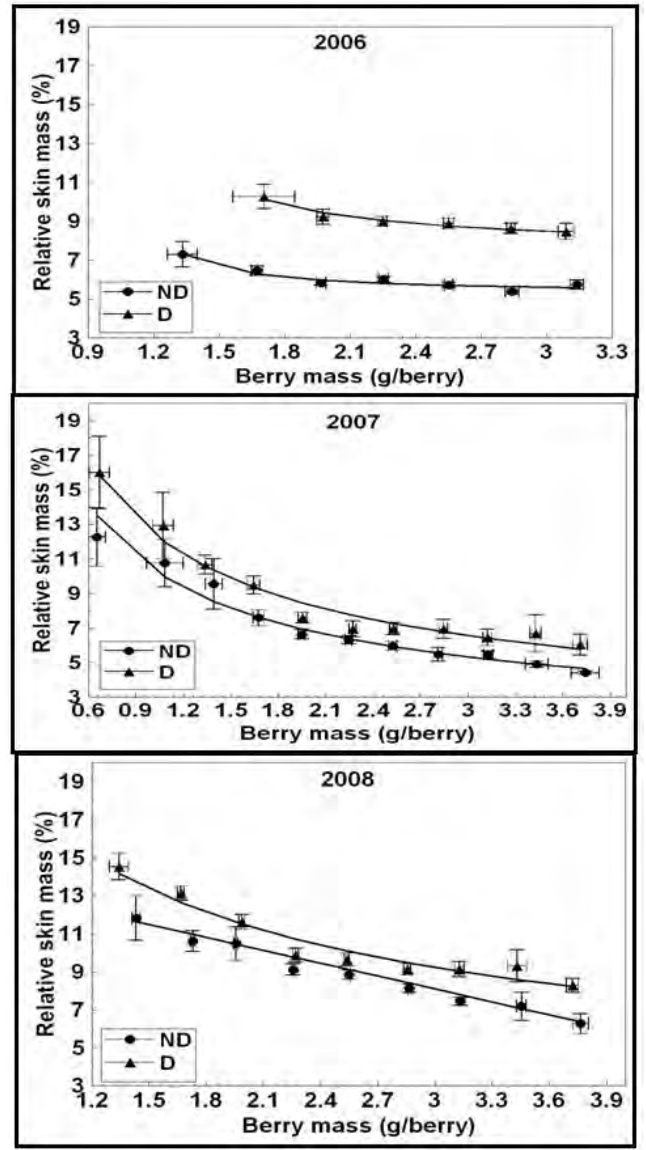
Fig. 2 - Correlation between relative skin and berry mass in 2006, 2007 and 2008 for non defoliated and defoliated Barbera grapevines (from Poni and Bernizzoni,